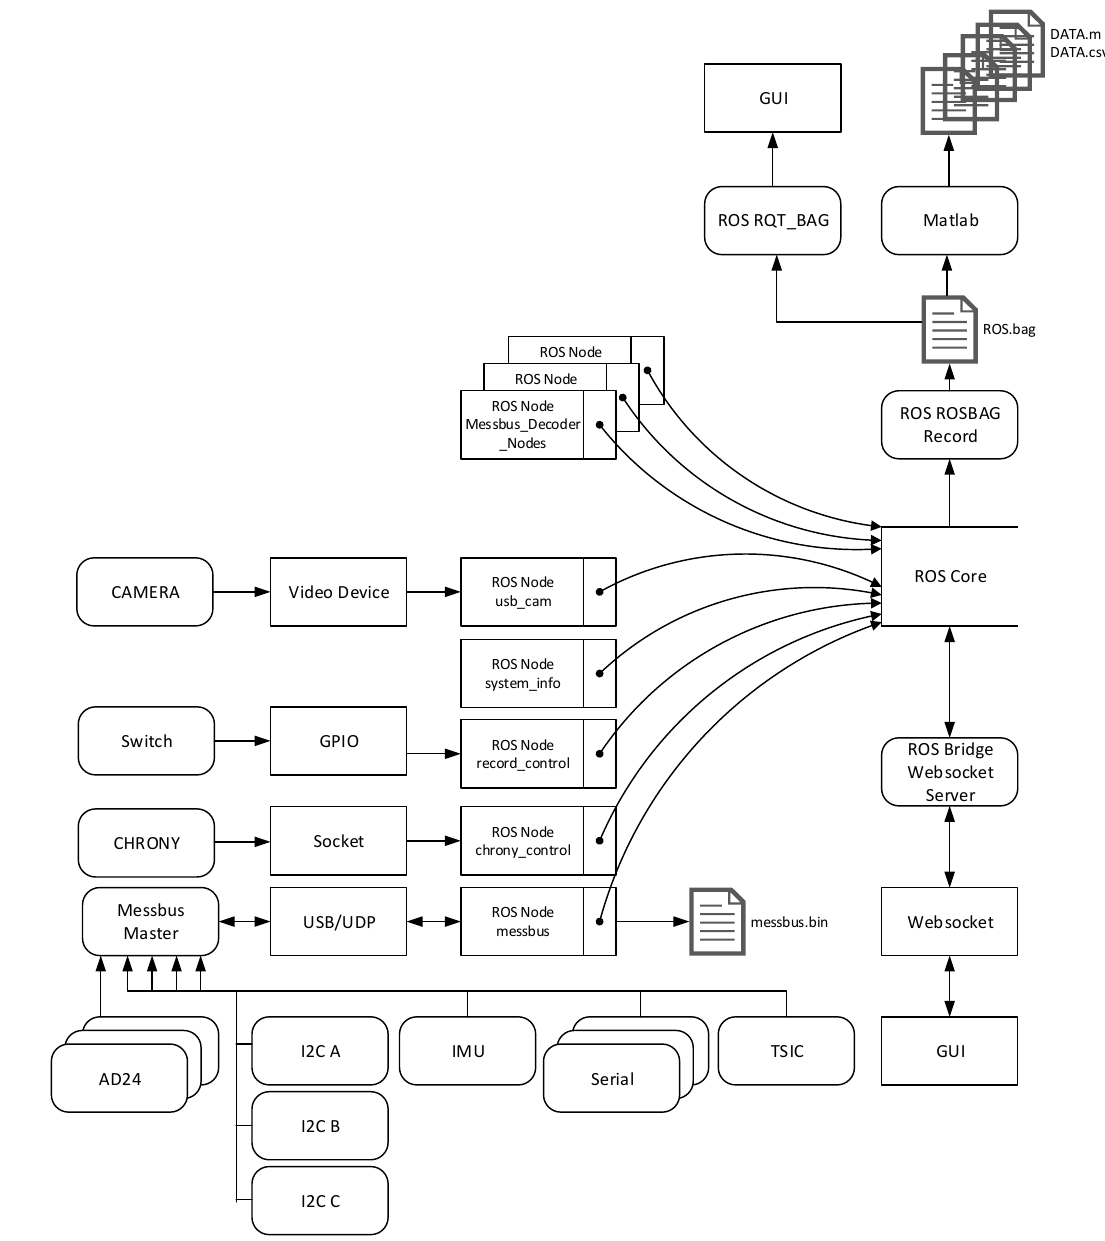
Figure 7. Representation of the MesSBAR data